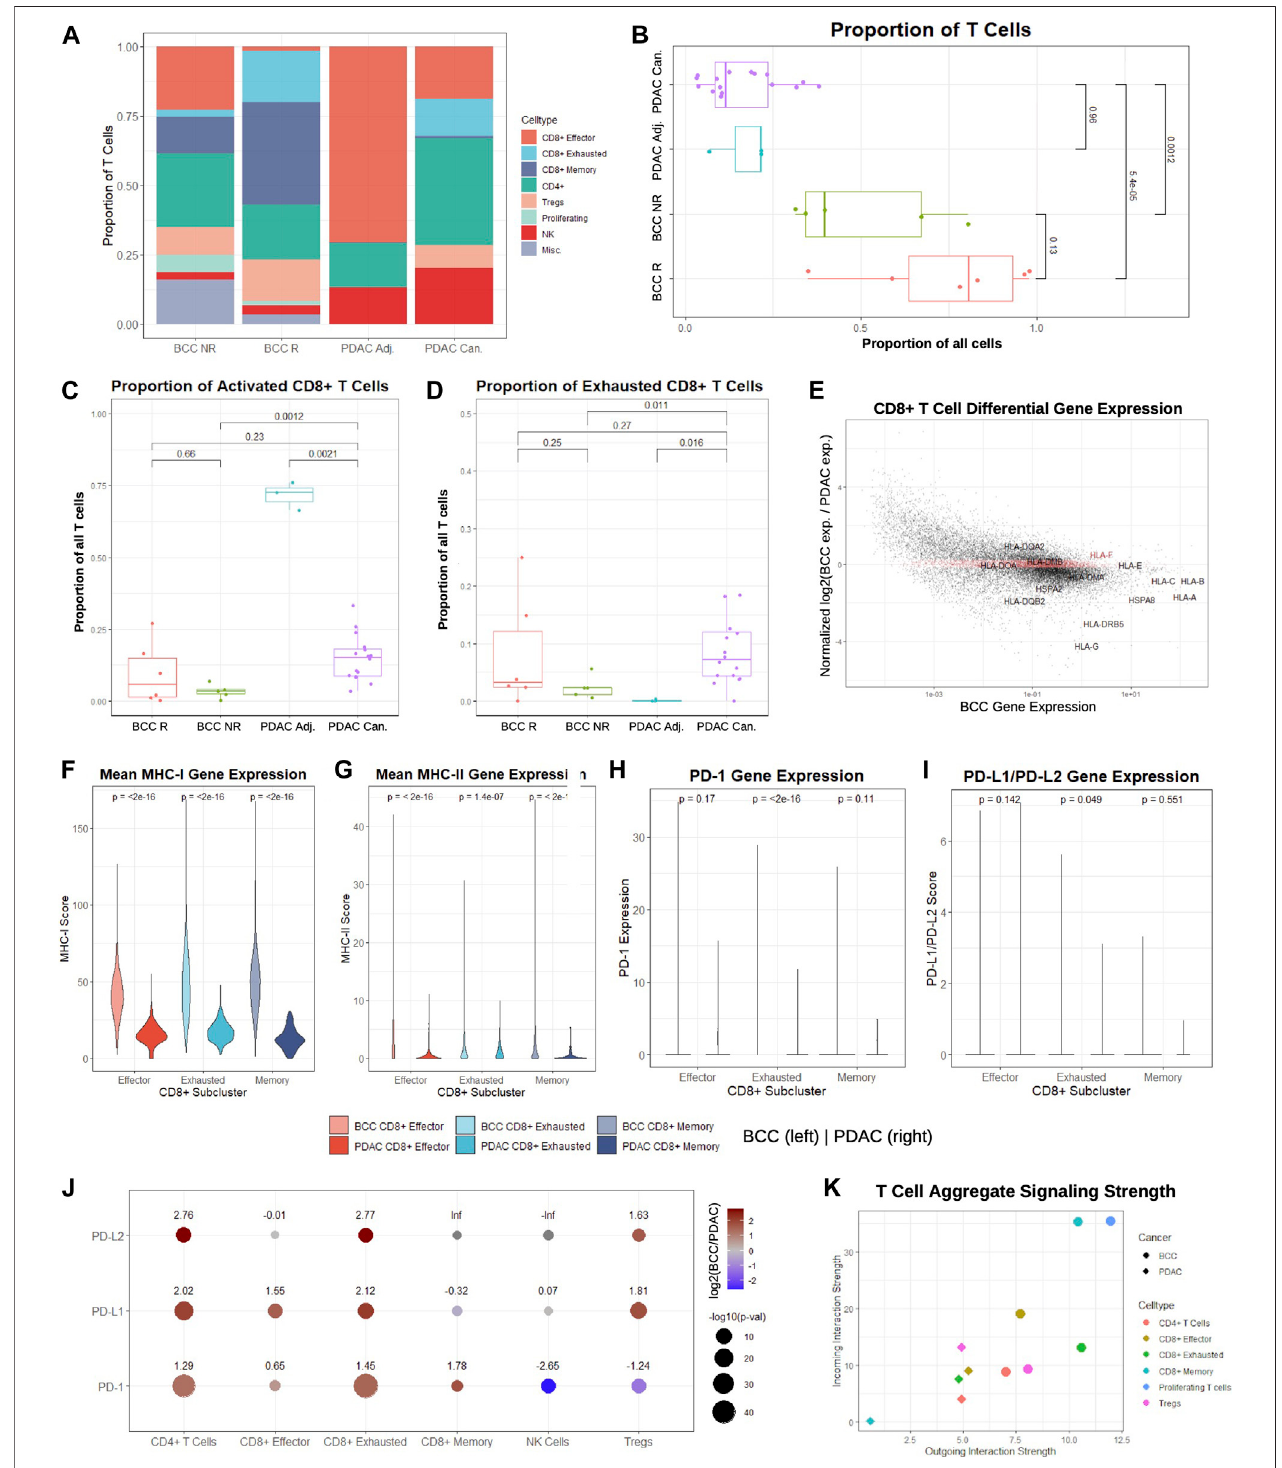
FIGURE2| CD8 + TcellsinBCCexhibithighersignalingstrengthandMHC-I/PD-1pathwayexpressioncomparedtoPDAC. (A) ProportionofTcellsubclustersinBCC(R (cid:1) Responsive, NR (cid:1) Nonresponsive) and PDAC (Can. (cid:1) Cancerous, Adj. (cid:1) Adjacent) samples. (B) Per-patient comparison of the proportion of all cells that are T cells. (C, D) Per- patient comparison of the proportion of T cells that are (C) CD8 + effector and (D) CD8 + exhausted. (E) Differential gene expression in CD8 + T cells, BCC vs PDAC (positive fold change indicates higher expression in BCC); the top 2000 genes with the lowest absolute value normalized fold change in expression are highlighted in red. (F-I) Per-cell comparisonbetweenBCCandPDACCD8 + Tcellsubclusterson (F) meanMHC-I, (G) meanMHC-II, (H) PD-1,and (I) meanPD-L1/PD-L2geneexpression. (J) Comparisonof fold change between average PD-1 pathway gene expression of BCC and PDAC T cell subclusters; positive values indicate greater expression in BCC. (K) Comparison of aggregate outgoing and incoming signaling strength between BCC and PDAC T cell subclusters.